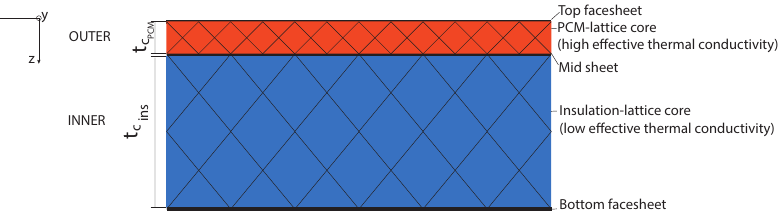
Figure 6. Schematic of a hierarchical lattice core ITPS, in which the PCM is embedded in the outermost core (orange), and a fibrous high temperature insulation is embedded in the innermost core